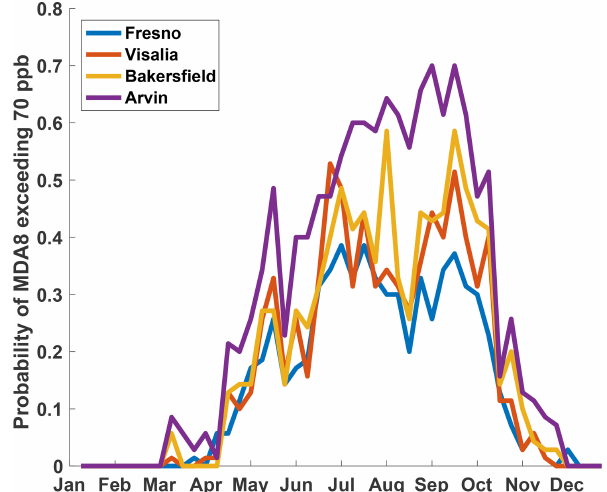
Figure 2. The probability of an MDA8 exceeding 70ppb each week of an annual cycle at four sites in the SJV, from north to south: Fresno, Visalia, Bakersfield, and Arvin (see Fig. 1). The data are from the CARB network from 2006 to